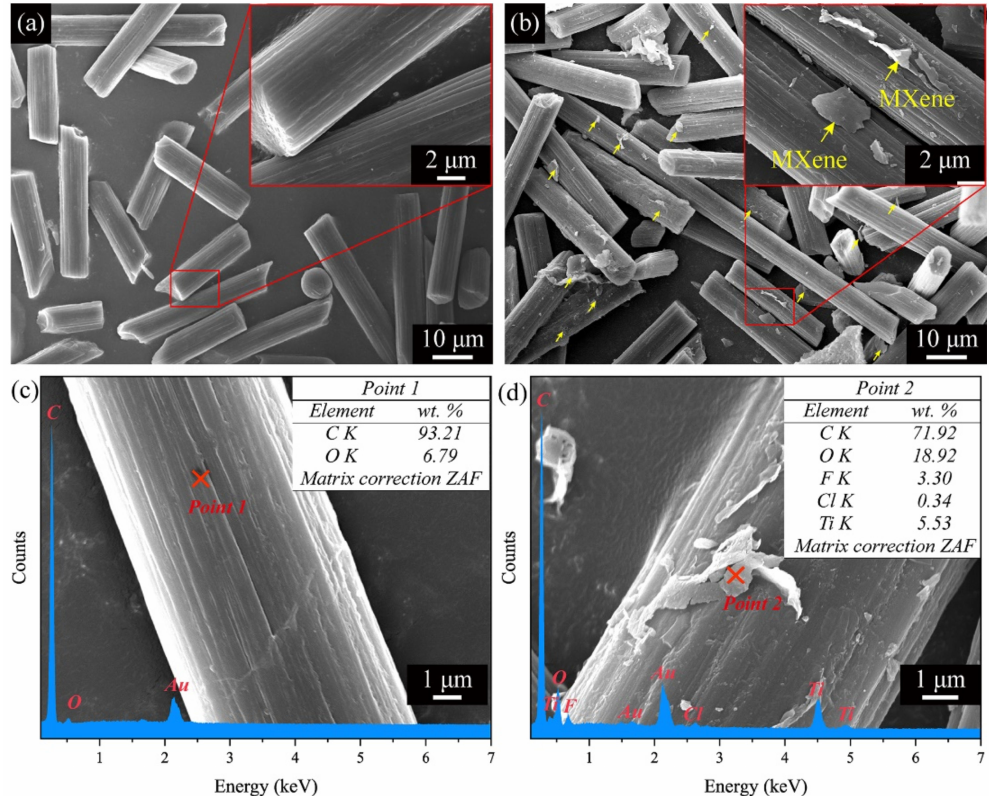
Figure 2. SEM images for ( a ) ASCFs and ( b ) MXene functionalized ACSFs. High-magnification SEM images and EDS results of ( c ) ASCFs and ( d ) MXene functionalized ACSFs.